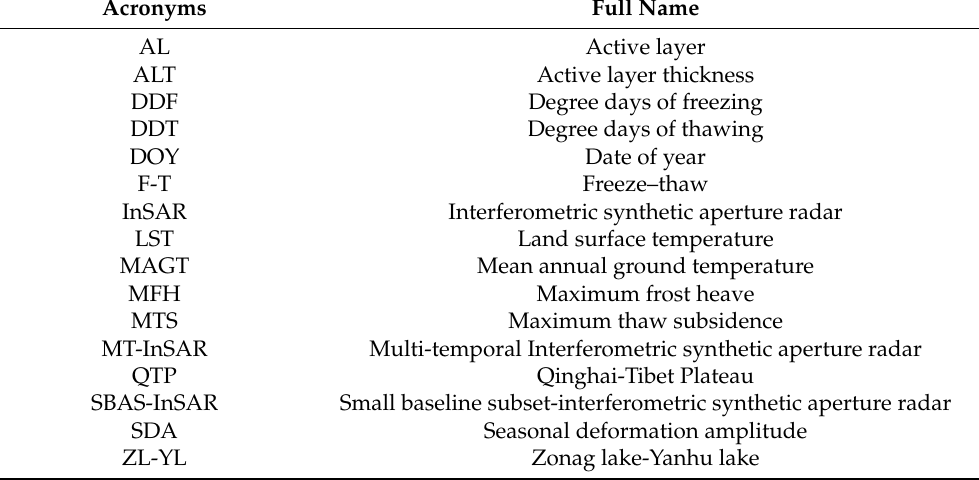
Table 7. List of